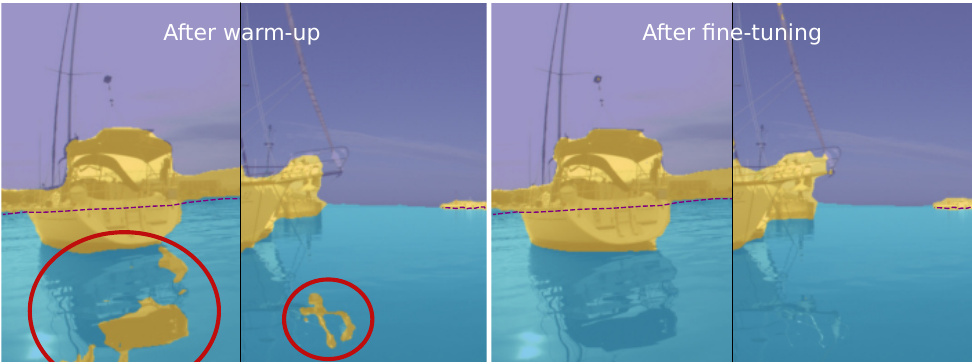
Figure 5. The network predicts false positives (highlighted with red circles) on, e.g., reflections after the warm-up phase ( left ), while performance improves substantially with fine-tuning on re-estimated labels ( right